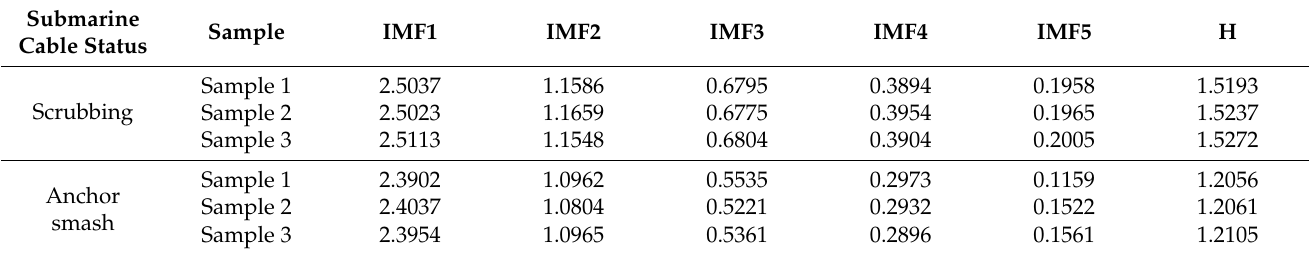
Table 1. Singular values and the entropy of singular values for different submarine cable states.